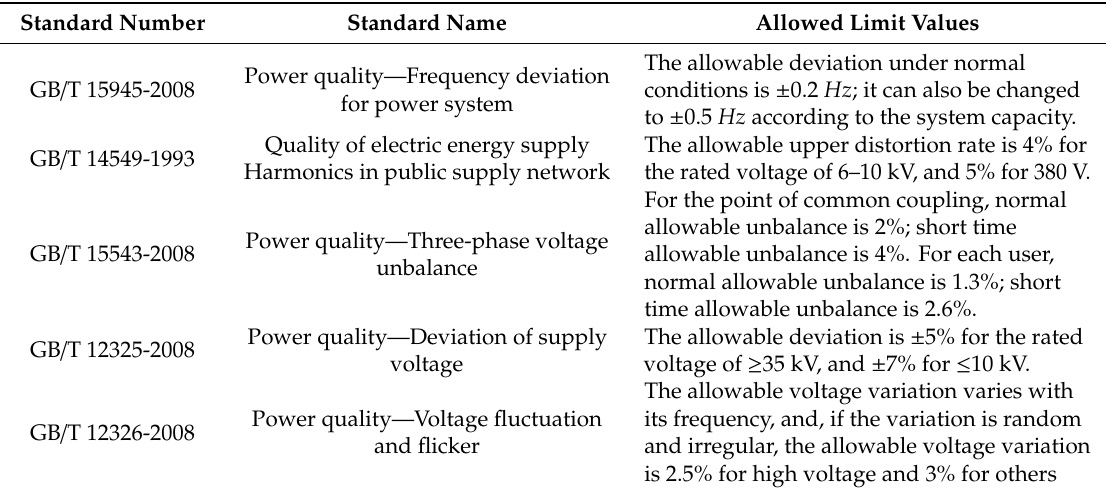
Table 1. The allowable limits of steady-state power quality indicators in China’s national